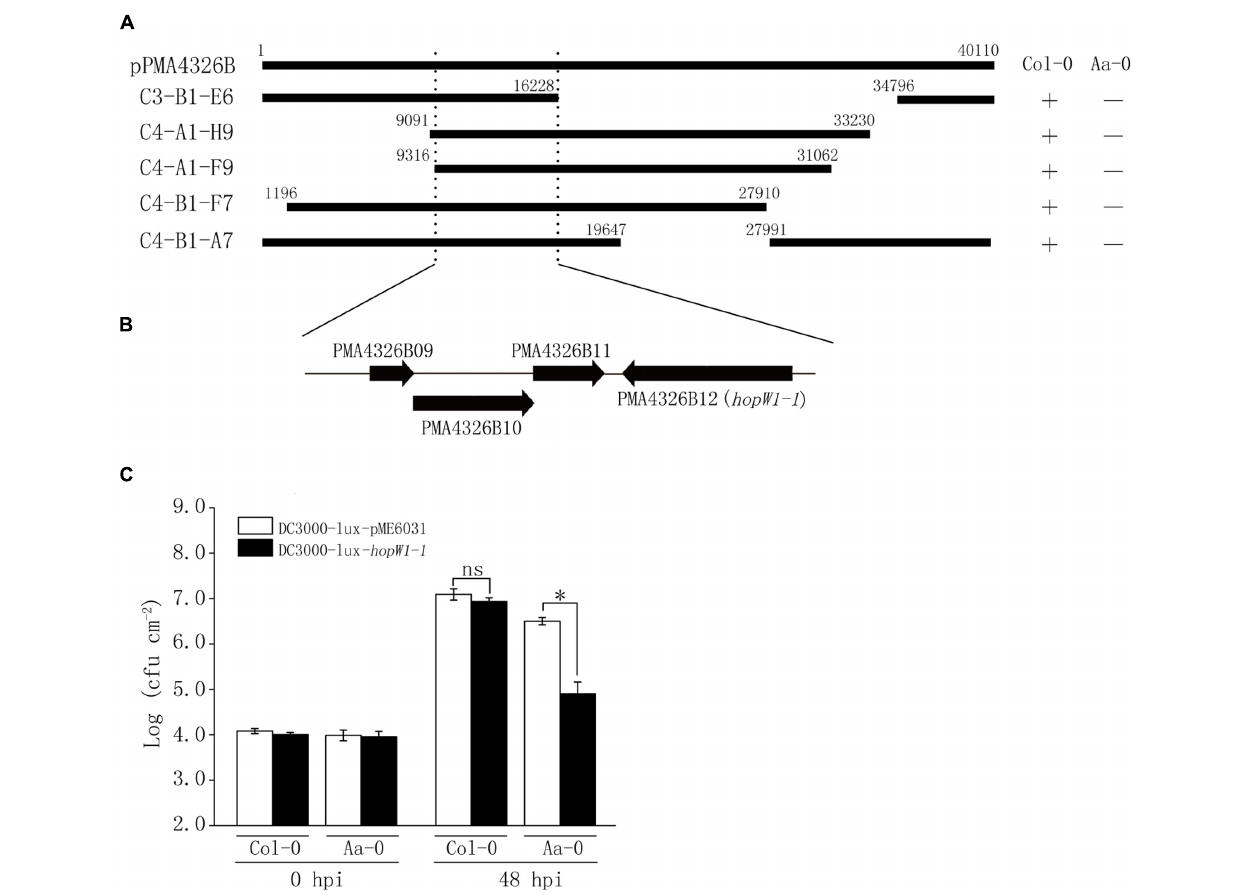
FIGURE 5 | Identification from ES4326 of the effector gene hopW1-1 that selectively reduced the bacterial growth on Aa-0. (A) Cosmid clones capable of reducing bacterial growth on Aa-0 share a common region of pPMA4326B from ES4326. Top bar denotes the linearized pPMA4326B in the full length of 40,110 base pairs. Each cosmid is marked with numbers showing the positions of insert ends. “+” indicates that the growth of bacterial cosmid clone in planta was similar to that of empty vector control. “–” indicates that the growth of bacterial cosmid clone in planta was significantly reduced compared with vector control. (B) Annotated genes in the minimal region of pPMA4326B shared by all five cosmid clones. (C) The effector gene hopW1-1 selectively reduced the growth of DC3000-lux in Aa-0 but not Col-0 plants. Plants were pressure inoculated with bacteria at OD 600 = 0.01. Bacterial growth was determined by counting colony forming unit (cfu) of three leaf disks from each plant and at least four plants were used in each treatment. Data shown are means ± SD ( n = 12). The asterisk indicates a significant difference between treatments (Student’s t -test, P < 0.05). “ns” denotes no significant difference. This experiment was repeated three times with similar